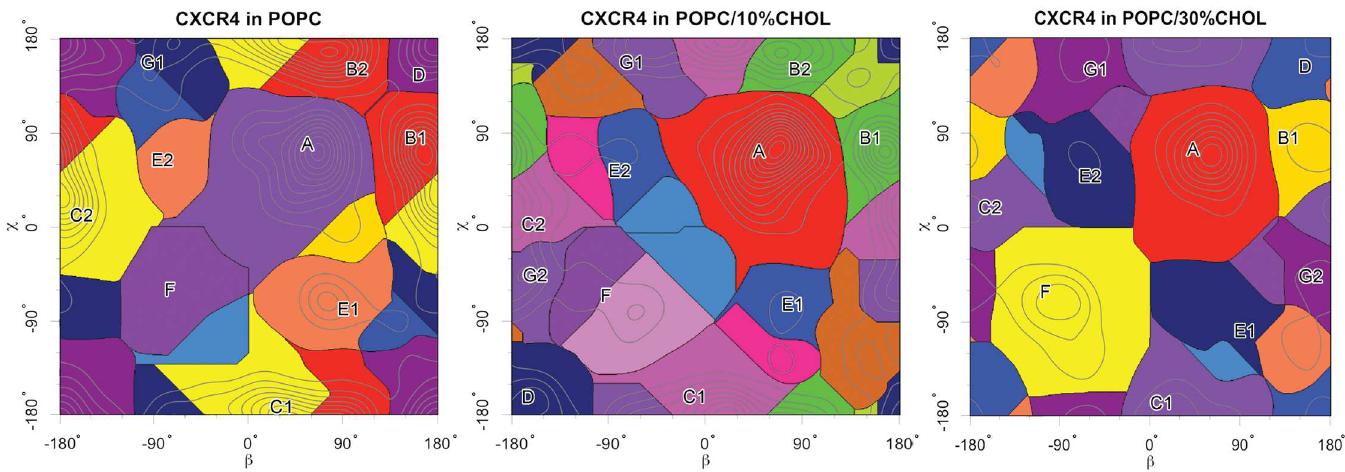
Fig 10. Spreading of each maximum in different dimerization set-ups.